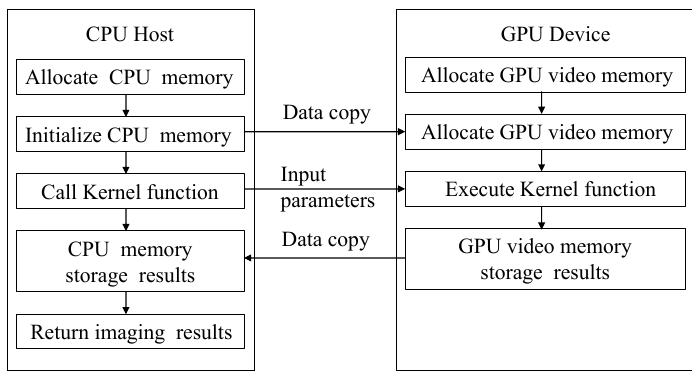
Figure 6. Antenna pattern preprocessing flowchart.